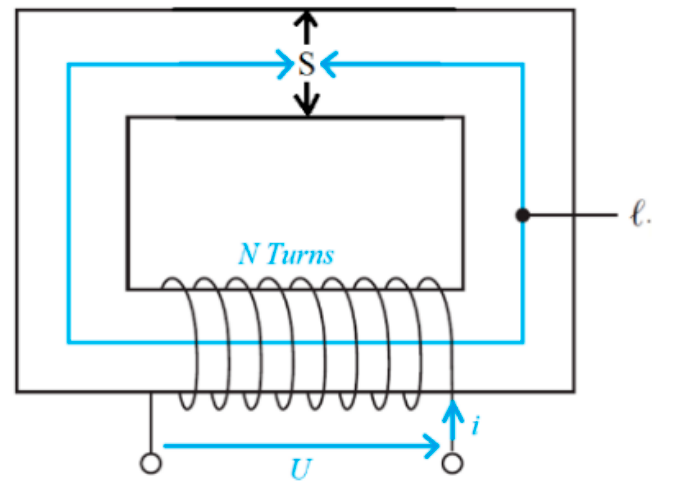
Figure 5. Basic ferromagnetic circuit.